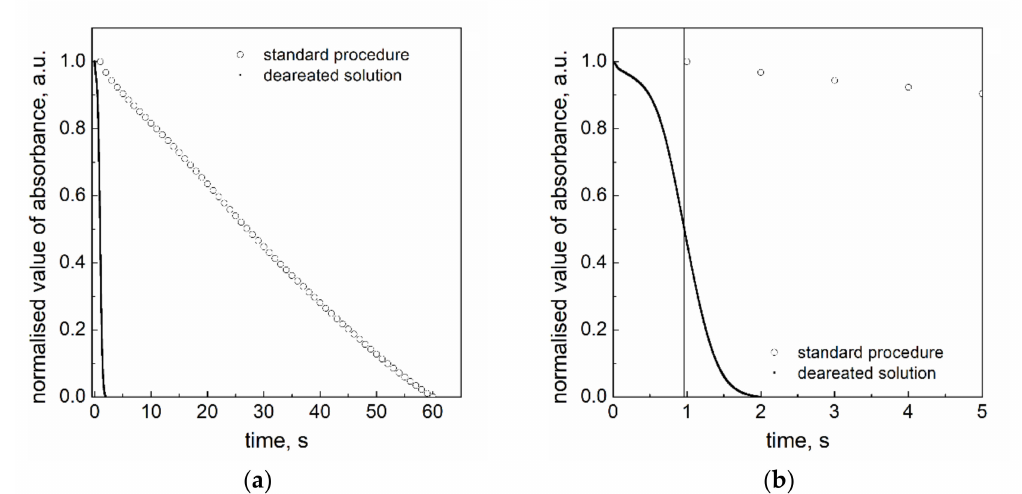
Figure 6. ( a ) Kinetic curves obtained for the reaction between platinum(IV) chloride complex ions and sodium borohydride at a standard procedure and in the case of deaerated solution; ( b ) kinetic curves registered in a short time. Conditions: C 0,Pt(IV) = 0.05 mM, C 0,NaBH4 = 3.0 mM, T = 25.0 ± 0.1 ◦ C, pH = 12.9 ±